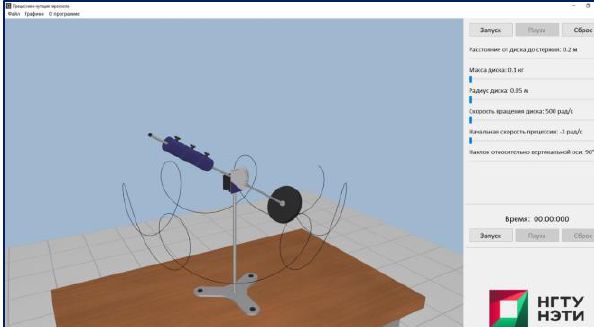
Fig.2. Virtual lab “Precession and nutation of a gyroscope”